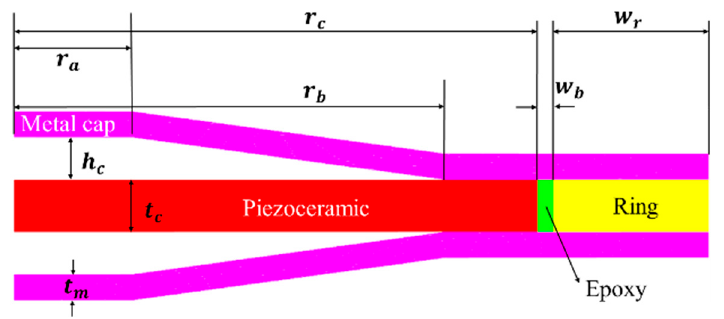
Figure 1. 2D axisymmetric finite-element analysis (FEA) model of the cymbal